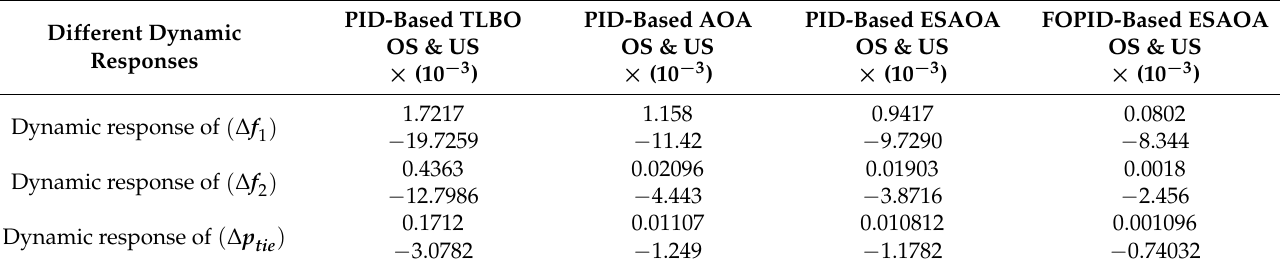
Table 7. Transient response specifications of the investigated system for scenario